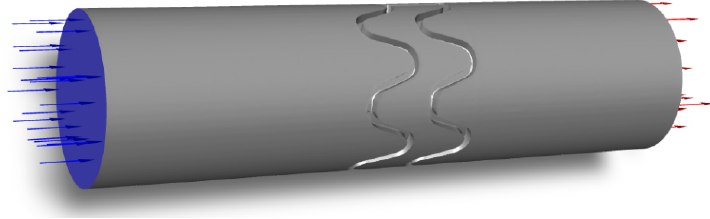
Figure 5. Finite element model of blood flow in the CFD module.